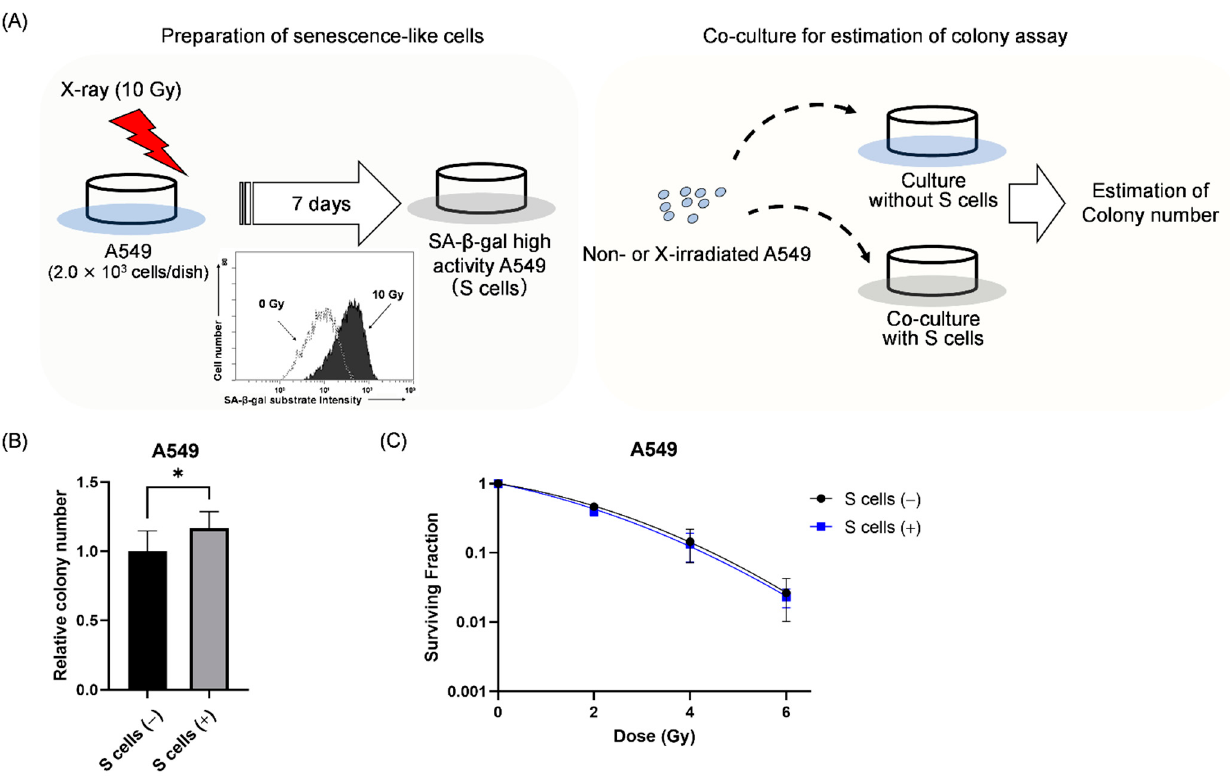
Figure 4. Effect of co-culture with senescence-like A549 cells on the survival of non- and irradiated A549 cells. ( A ) A schematic of the co-culture experiment is shown. A549 cells irradiated with 10 Gy were cultured for 7 days to induce senescence-like cells (S cells). Non-irradiated and X-ray irradiated A549 cells were seeded in dishes with or without S cells for the colony-forming assay. ( B ) The relative colony number of non-irradiated A549 cells in the presence and absence of S cells is shown. ( C ) The surviving fraction of A549 cells with and without S cells is shown. S cells (+) and S cells ( − ) indicate with and without S cells, respectively. Data are presented as the mean ± SD of independent experiments. * p < 0.05.